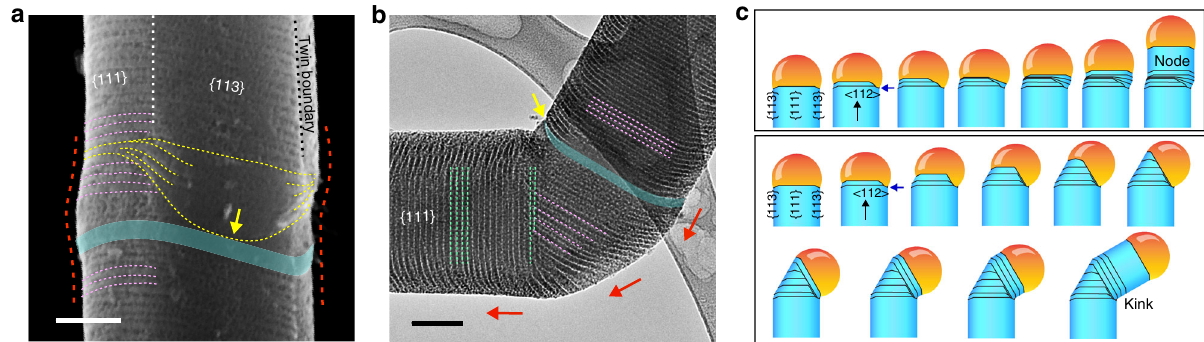
Fig. 5 Atomic gold patterns enable the study of the growth dynamics of existing structures. a A SEM image of a nanowire with a node. Yellow and pink dashed lines mark the evolution of the alloy droplet during node formation. The yellow arrow marks the pinning edge of the droplet on an intrinsic segment (cyan ribbon). Red dashed lines highlight the node evolution. Scale bar, 100 nm. b A TEM image of a kinked nanowire. Red arrows indicate the switches of the nanowire growth orientations. The yellow arrow marks the pinning edge of the droplet on the sidewall at an intrinsic segment (cyan ribbon). Pink and green dashed lines highlight the grooves in the original and the new arms, respectively. Scale bar, 100 nm. c Schematics of the growth dynamics. A node is formed when the droplet edge fi rst gets pinned heavily on one facet (blue arrow) while the rest of the droplet continues to evolve. Subsequent unpinning recovers the original growth behavior, leaving a node behind. In the formation of a kinked unit, the pinned droplet edge remains attached to the Si sidewall (blue arrow), while the growth orientation switches between two < 112 > directions by shrinking/enlarging the Au/Si alloy droplet/Si nanowire interfaces that yield the original/new arm